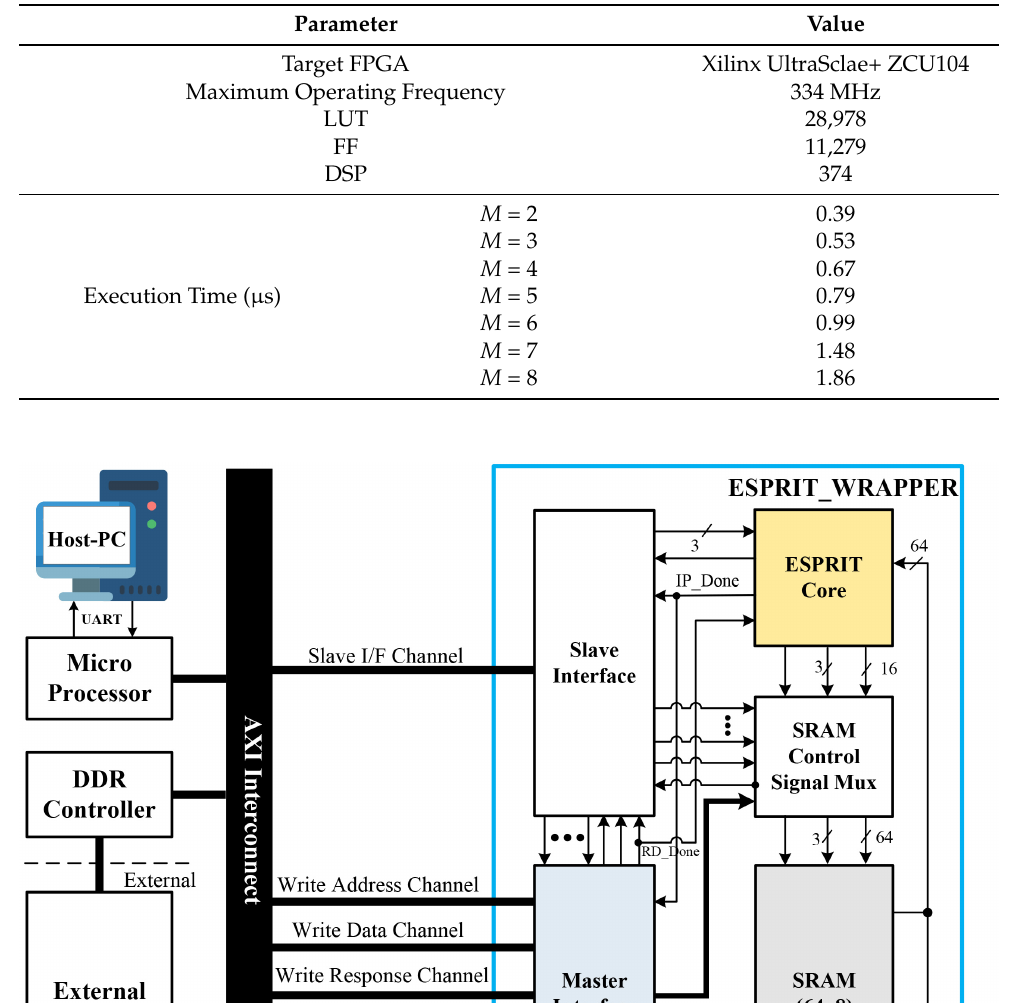
Table 2. Implementation results of proposed ESPRIT processor based on Xilinx Zynq UltraScale+